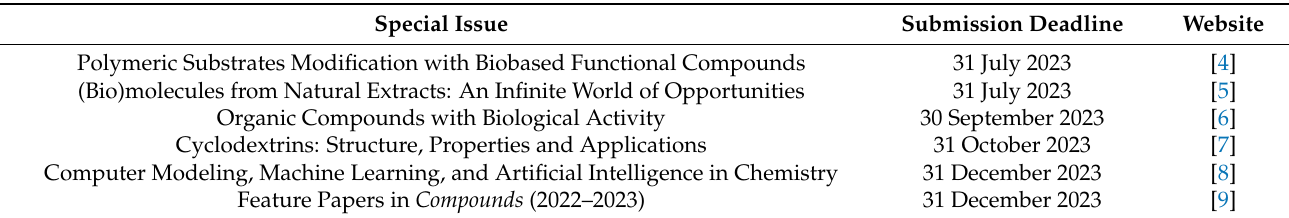
Table 1. Special Issues Open for Submissions.